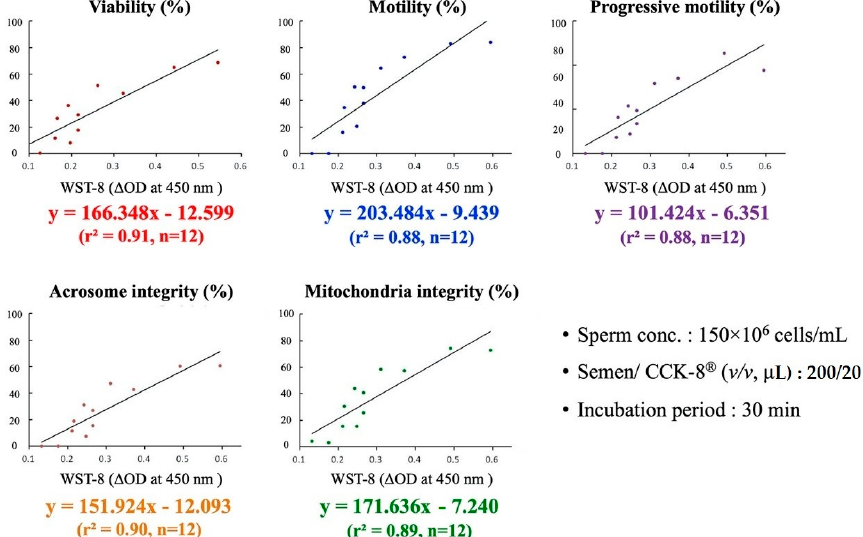
Prediction model and formula between the WST-8 reduction rate ( ∆ OD) and boar sperm viability (%), sperm motility (%), progressive sperm (%), acrosome integrity (%) and mitochondrial integrity (%), at a Figure 2. Linear regression and prediction models for sperm concentration of 150 × 10 6 cells/mL. sperm concentration of 150 × 10 6 cells / mL after 30 min incubation at 37 ◦ C with a semen / CCK-8 ® ratio of 200 /